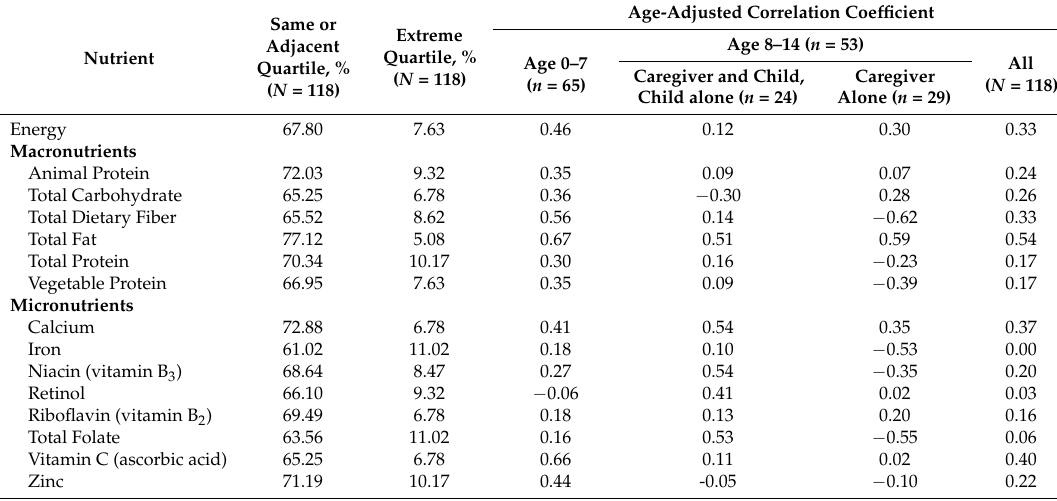
Table 3. Quartile classification and crude and age-adjusted correlation coefficients of select nutrients observed in the second-administered FFQ and mean 24-h diet recall. Same or Nutrient